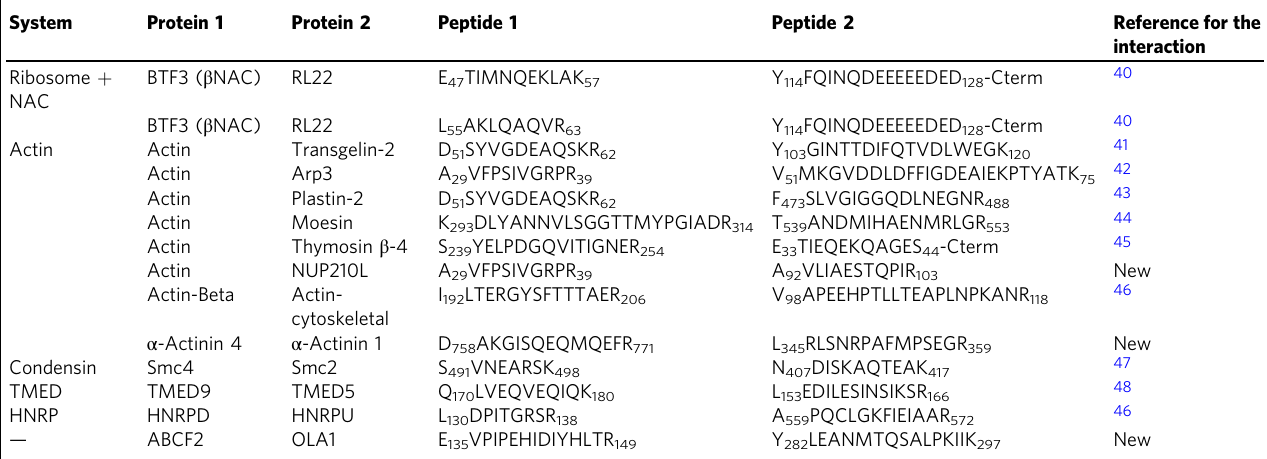
Table 1 Inter-protein cross-links that provide new in situ structural